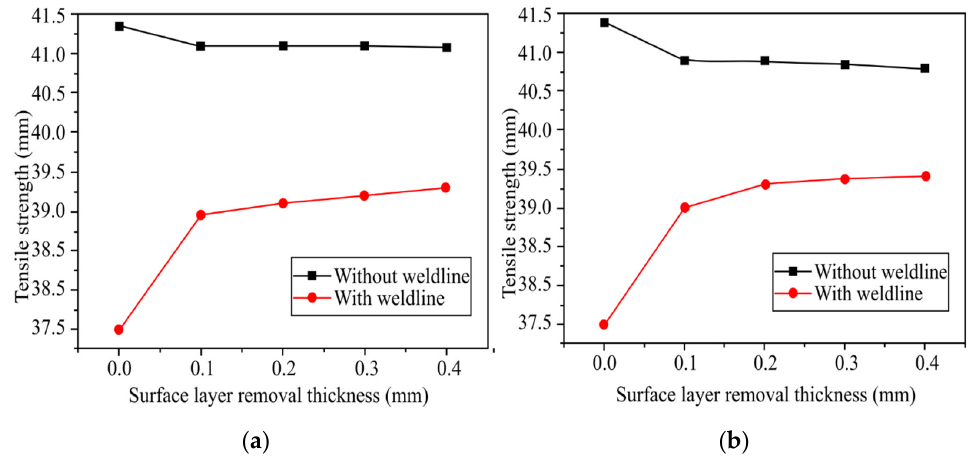
Figure 15. Tensile strength of RHCM parts: ( a ) when the surface layer was removed from the surface adjacent to the heated stationary half, and ( b ) when the surface layer was removed from the surface adjacent to the moving half of the surface [48].